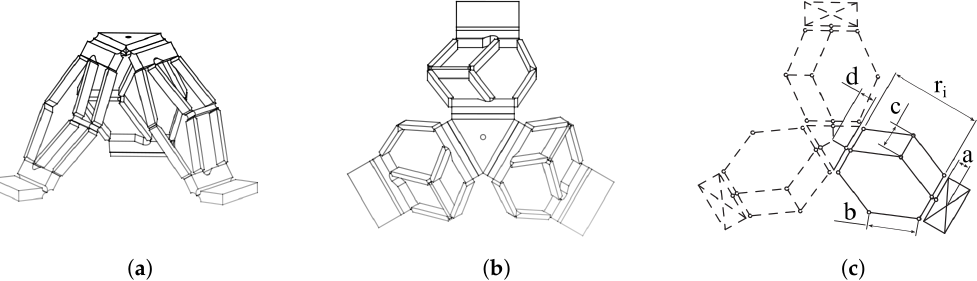
Figure 2. From the left, ( a ) a three-dimensional view of the mini-manipulator, ( b ) the corresponding upper view, and ( c ) the basic nomenclature adopted in the kinematic analysis for the i th leg, with i =